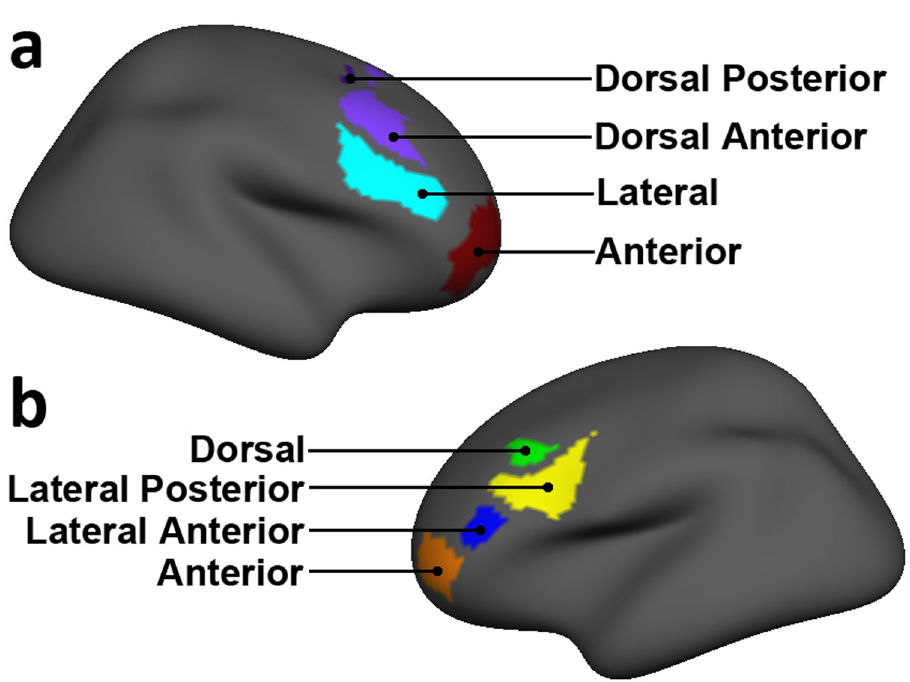
Figure 3. Lateral prefrontal cortex (LPFC) subregions. Renderings of LPFC subregions used in exploratory analyses of R1. The subregions were defined from LPFC splits of the Yeo resting-state atlas 17-network atlas 101 . Subregions are depicted for both right ( a ) and left ( b ) hemispheres. Note bilateral inconsistencies in LPFC subregional architecture. Renderings are depicted on an MNI